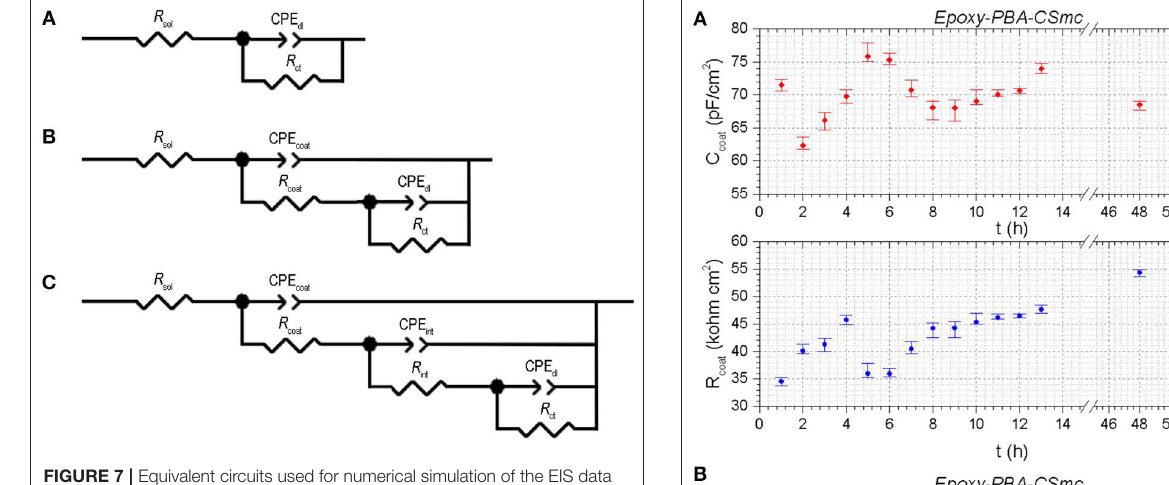
The pore resistance ( R coat ) for the scribed Epoxy-CSmc continuously decreases as the immersion time elapses and